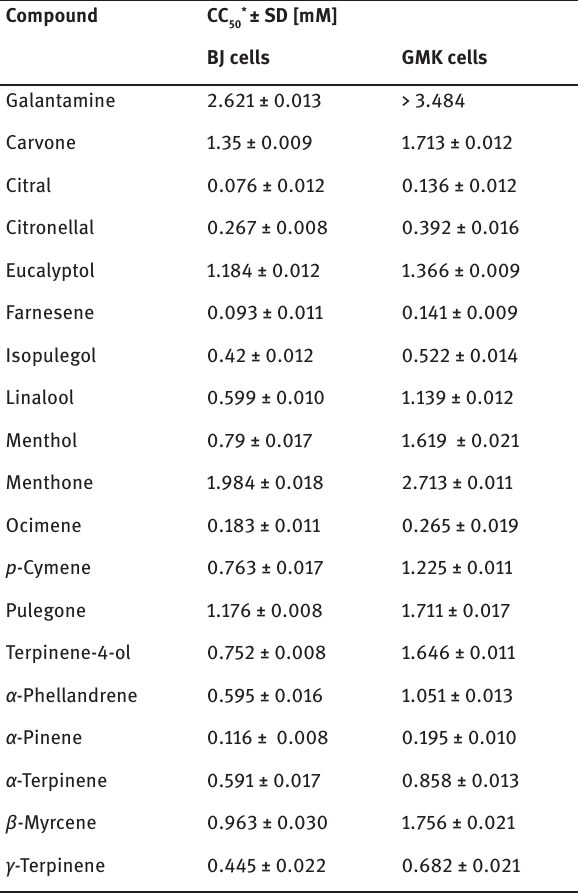
fibroblast cell line (BJ cells) and green monkey kidney cell line (GMK cells) assessed using MTT test after 24-hour